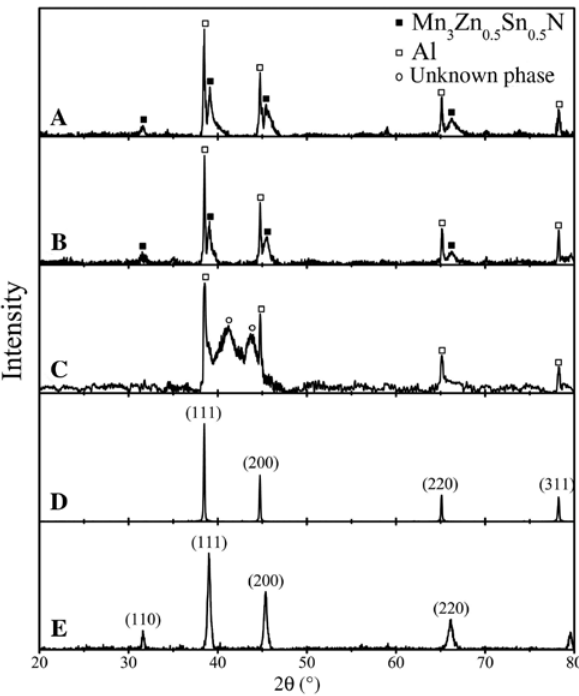
Zn Sn N/Al 3 0.5 0.5 Figure 4: Linear thermal expansion of 30 vol.%-Mn composites at different sintering